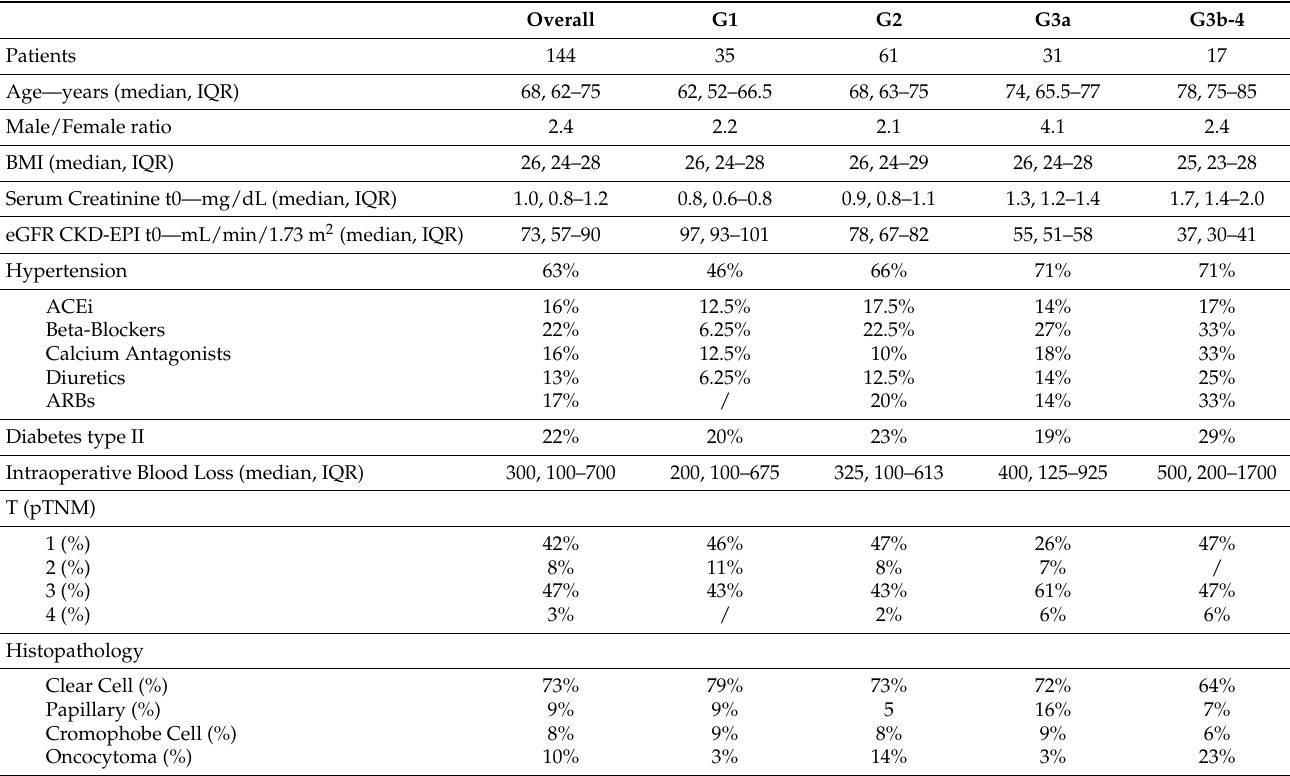
Table 1. Baseline